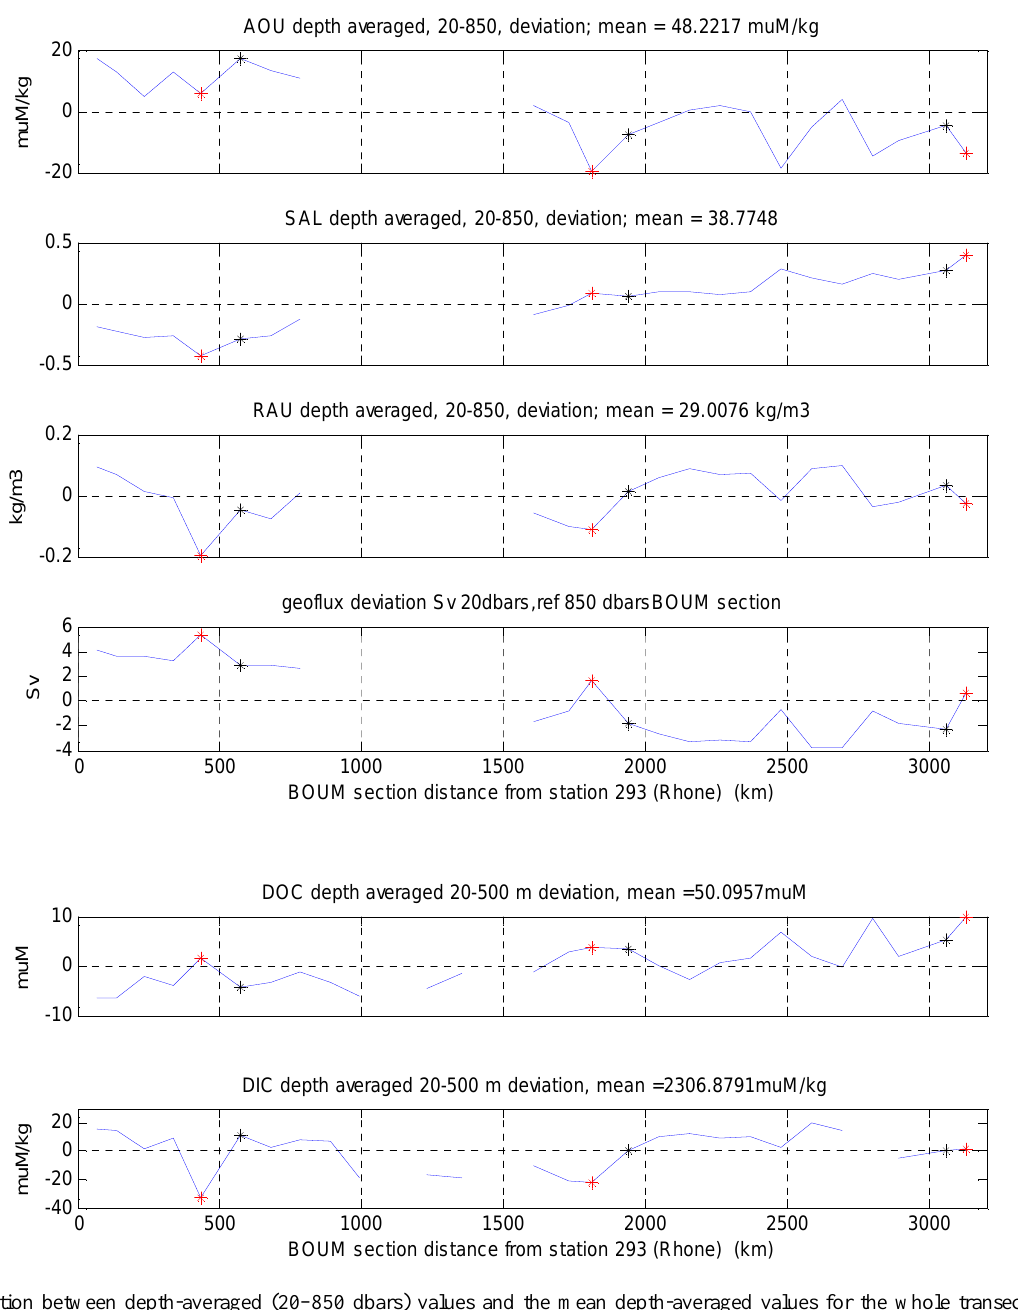
Fig. 7. Deviation between depth-averaged (20–850 dbars) values and the mean depth-averaged values for the whole transect of the fol- lowing parameters: AOU (µmolkg − 1 ) ; S (PSU); σ (kgm − 3 ) ; deviation to the mean of the baroclinic geostrophic flux function F (Sv) at 20dbars when considering a reference depth at 850dbars (0Sv); deviation of depth-averaged (20–500dbars) to mean value of dissolved organic carbon (DOCµmolkg − 1 ) and dissolved inorganic carbon (DICµmolkg − 1 ) along the BOUM transect. The mean integrated values for the transect are respectively mean(AOU) = 48.2µmolkg − 1 , mean( S ) = 38.775, mean( σ) = 29.008kgm − 3 , mean(DOC) = 50.1µM and mean(DIC) = 2306.9µmolkg − 1 . The positions of eddies A, B, and C are indicated with red crosses and the positions of the nearest casts are indicated by black crosses. No values were obtained when bottom depths were < 850 dbars (or < 500 dbars), as occurred near the Rhˆone river mouth or in the Sicilian